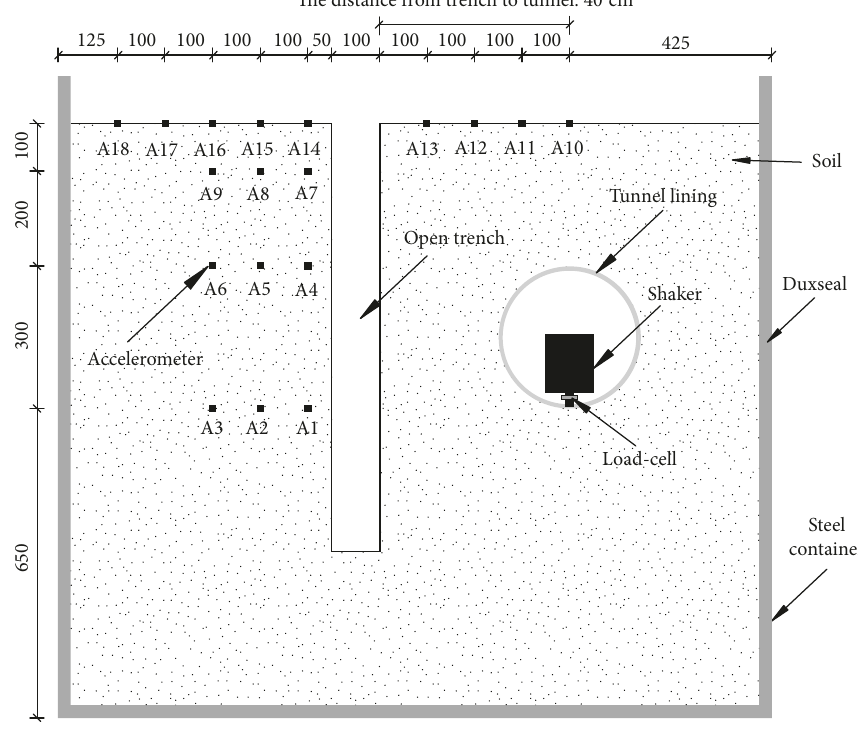
Figure 1: Acceleration sensor layout (mm).